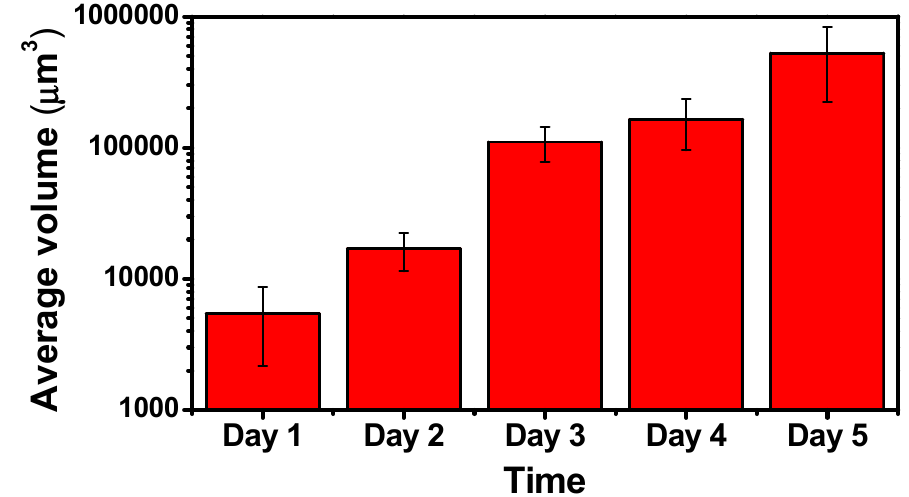
Figure 7. Average volume of cell colonies. The data were generated from at least three repeated experiments. The error bars represent the standard deviations.